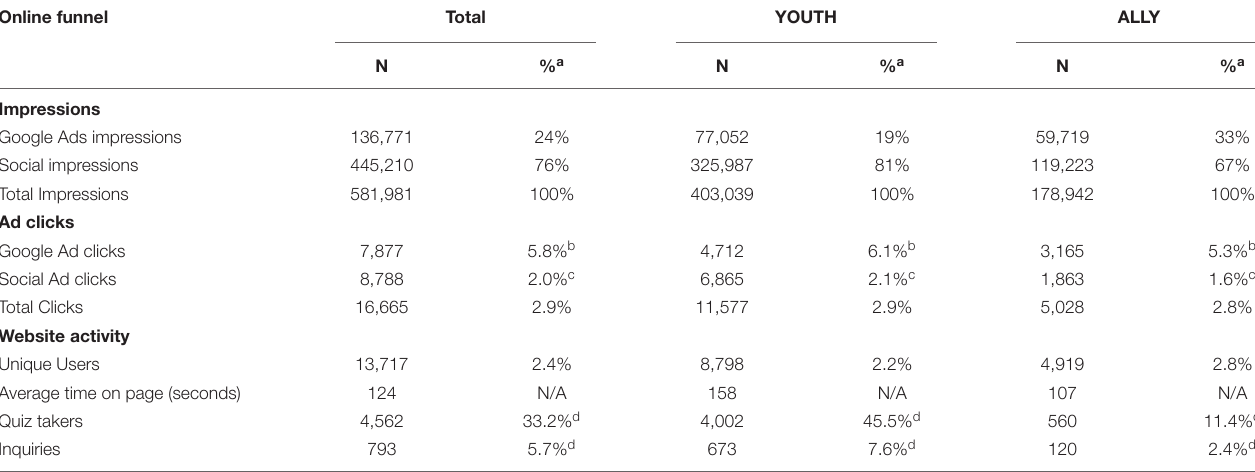
TABLE 2 | User journey from digital ad to active